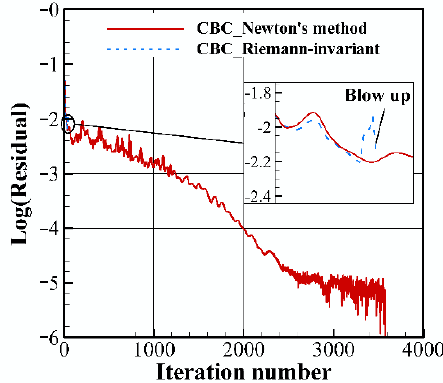
Figure 8. Convergence histories of HPCC simulation.